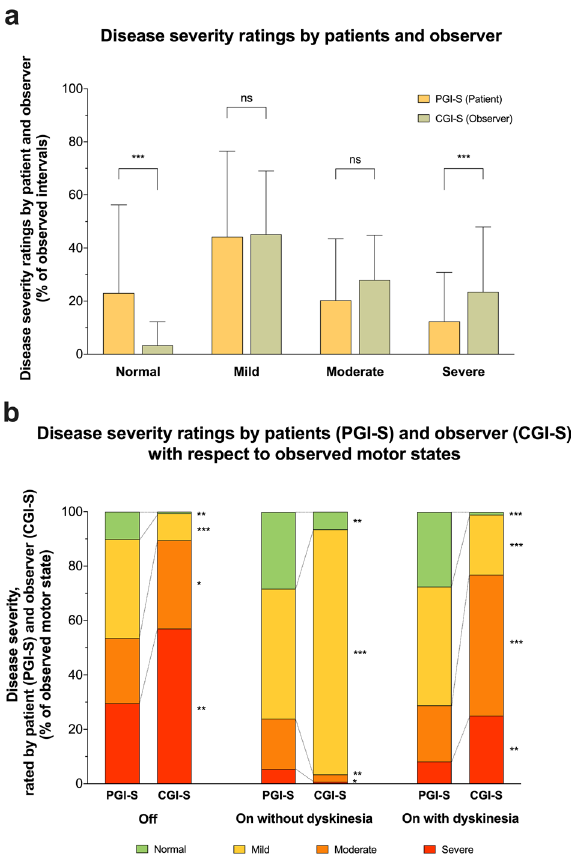
Fig. 4 Perception of disease severity by patients and observer on the Patient Global Impression of Severity (PGI-S) and Clinical Global Impression of Severity (CGI-S). a The mean proportions of 1947 simultaneous half-hourly performed disease severity ratings from 51 patients with Parkinson ’ s disease (yellow colour) and an independent clinical observer (green colour) using the Patient Global Impression of Severity (PGI-S) and Clinical Global Impression of Severity (CGI-S), respectively. b Illustrates the distribution of PGI-S and CGI-S ratings with respect to correspondingly observed motor states using the levels “ Normal ” (green colour), “ Mild ” (yellow colour), “ Moderate ” (orange colour) and “ Severe ” (red colour). All PGI-S and CGI-S values were originally each assessed with 7 severity grades, but then condensed to four levels to enhance clarity of this fi gure (please refer to the “ Methods ” section for more details). Values are means + standard deviations ( a ) and percentages b . * P < 0.05, ** P < 0.01, and *** P < 0.001 from Wilcoxon matched-pairs signed rank. ns not signi fi